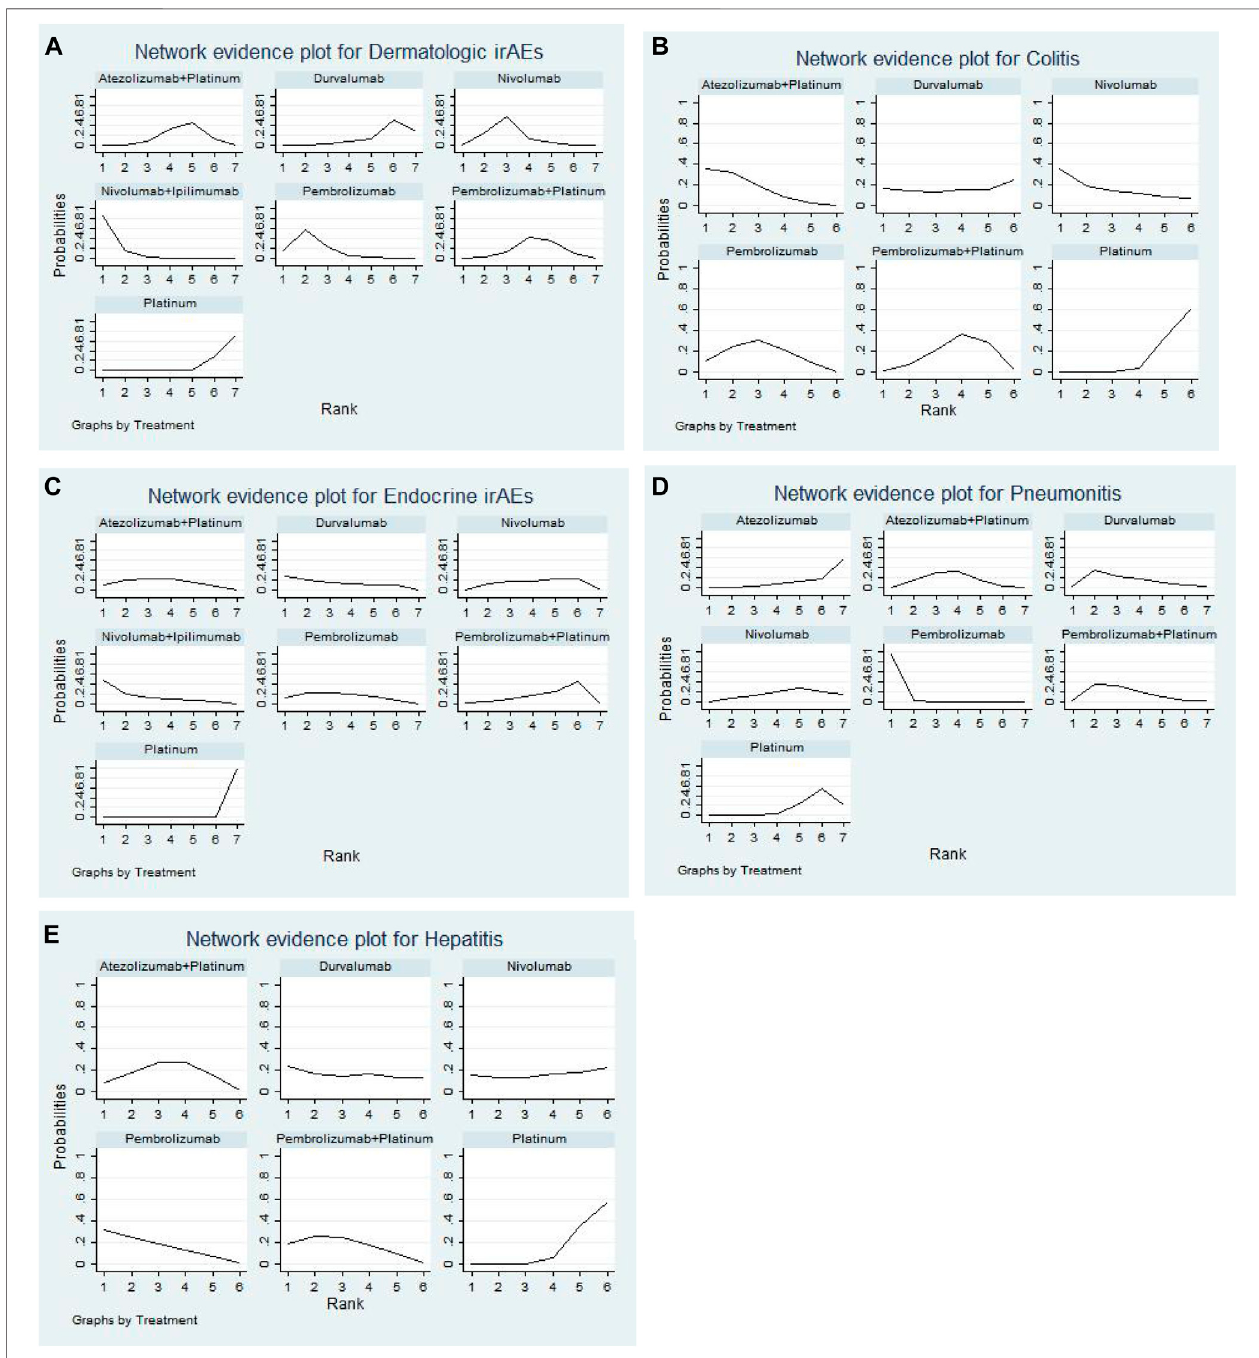
FIGURE 5 | Sequence diagram of the network meta-analysis. (A) Multiple treatment comparison for dermatologic irAEs based on SUCRA. (B) Multiple treatment comparison for colitis based on SUCRA. (C) Multiple treatment comparison for endocrine irAEs based on SUCRA. (D) Multiple treatment comparison for pneumonitis based on SUCRA. (E) Multiple treatment comparison for hepatitis based on SUCRA. (Platinum (cid:1) Platinum based chemotherapy).